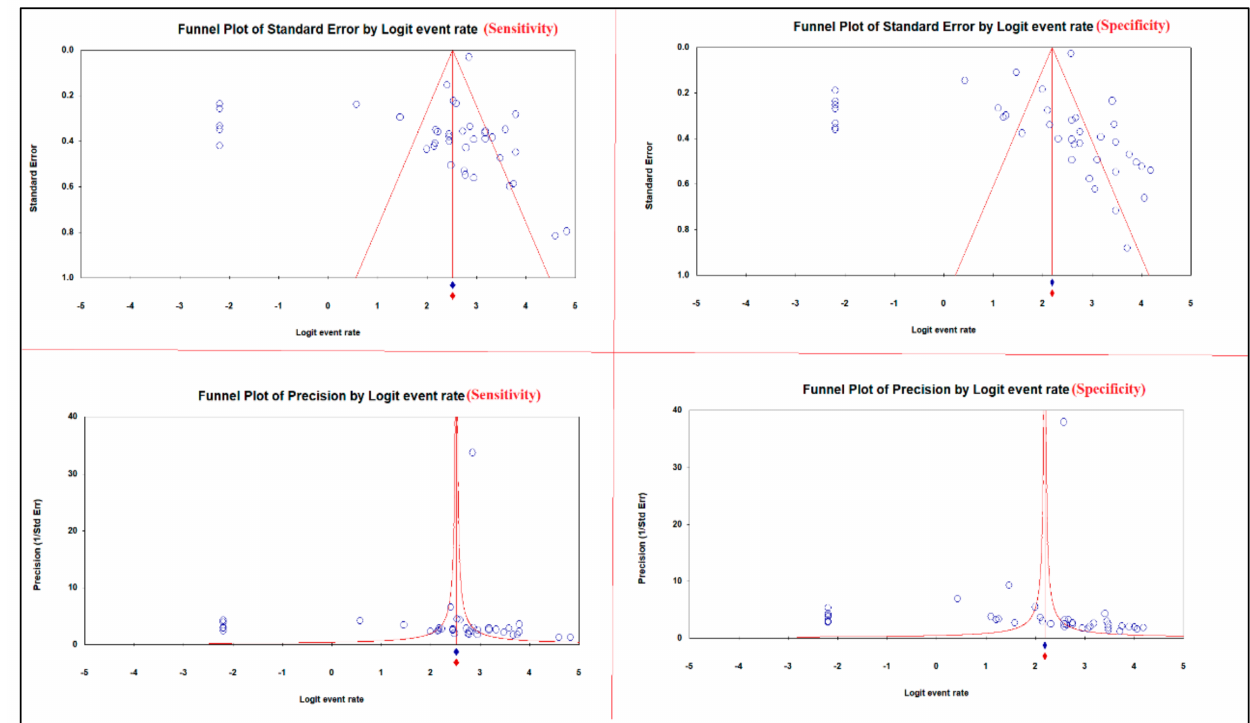
Figure 7. Publication bias of the sensitivity and specificity of 13 C/ 14 C-urea breath tests in the diagnosis of Helicobacter pylori infection.